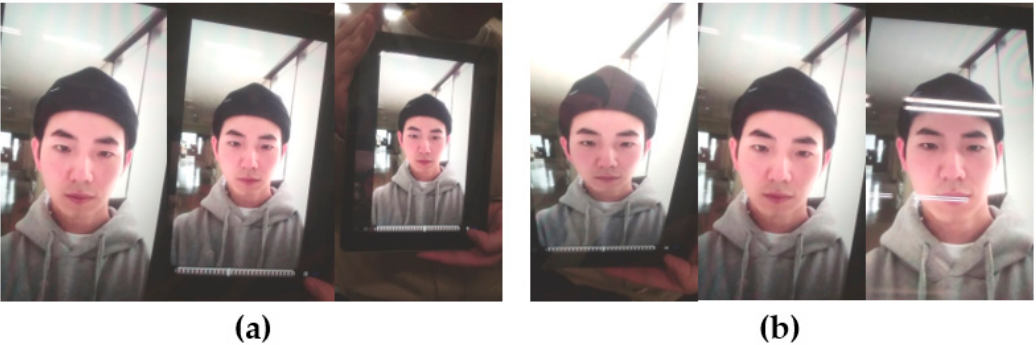
Figure 7. Samples of a replay video attack: ( a ) three distances (near, halfway, distant); ( b ) three angles (bottom, middle, top).